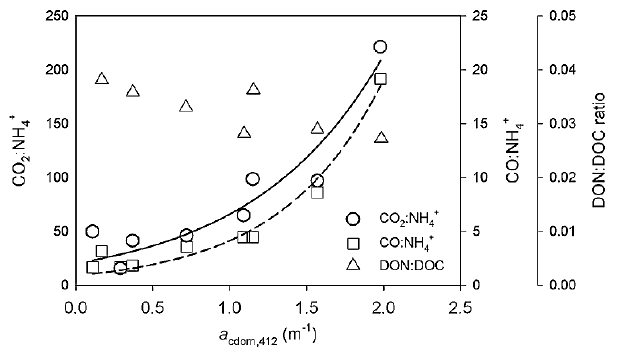
Fig. 10. Plots of photochemical molar ratios of CO 2 to NH + CO to NH + vs. CDOM absorption coefficient at 412nm. Data were 4 fitted to the equation of Y = 20 . 4exp ( 1 . 17 X) for CO 2 :NH + line; r 2 = 0 . 908, n = 8) and Y = 0 . 90exp ( 1 . 53 X) for CO:NH + (dashed line; r 2 = 0 . 968, n = 9). Superimposed is the plot of DON:DOC ratio vs. CDOM absorption